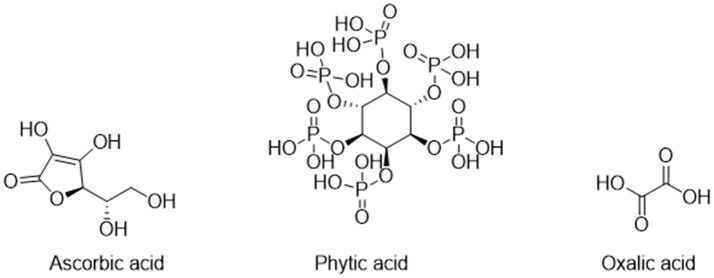
Structures of ascorbic acid (L-AA), phytic acid, and oxalic acid.